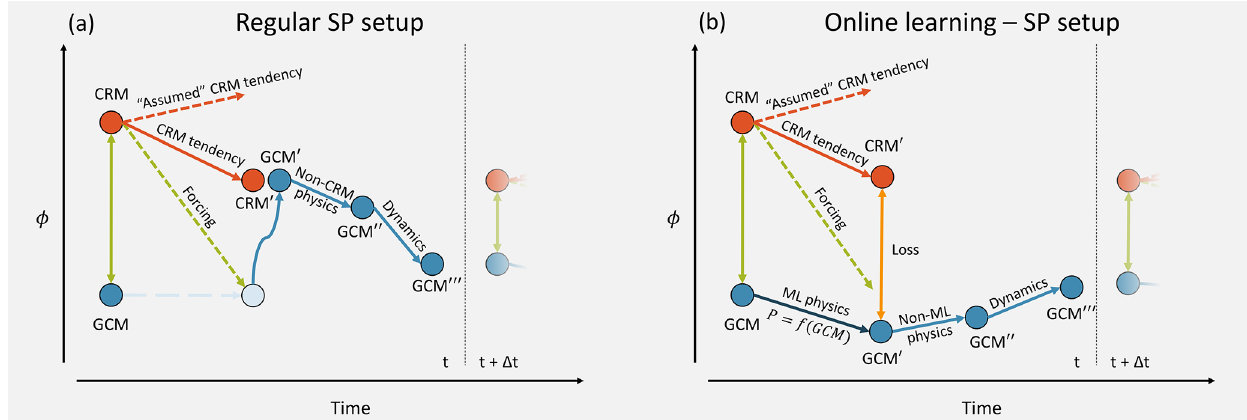
Figure 5. Evolution of a tracer φ during a regular SP step in (a) and for coupled learning in (b)